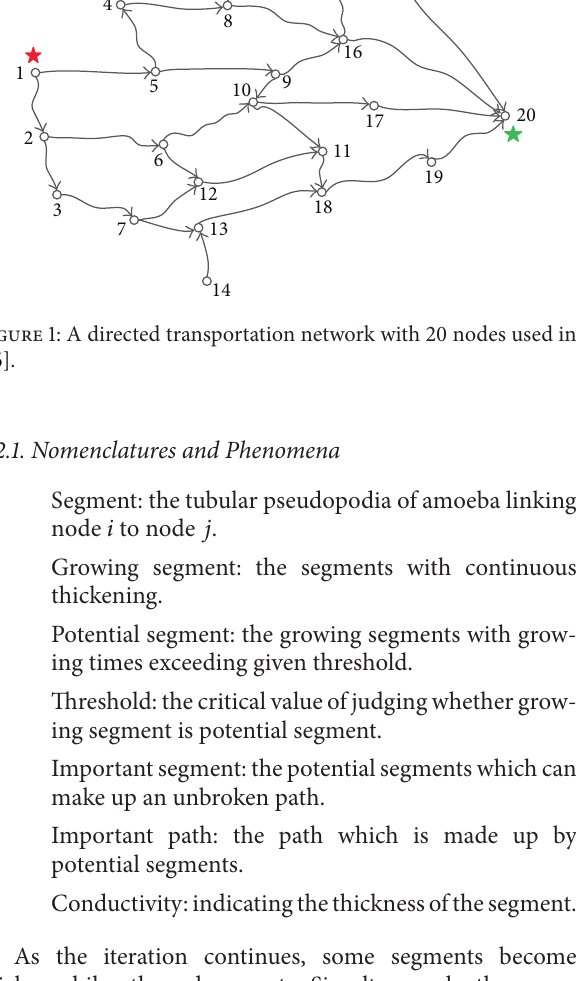
Table 1: Attribute value of each edge employed in